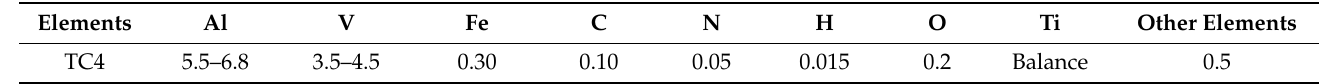
Table 1. The chemical composition of the TC4 (in